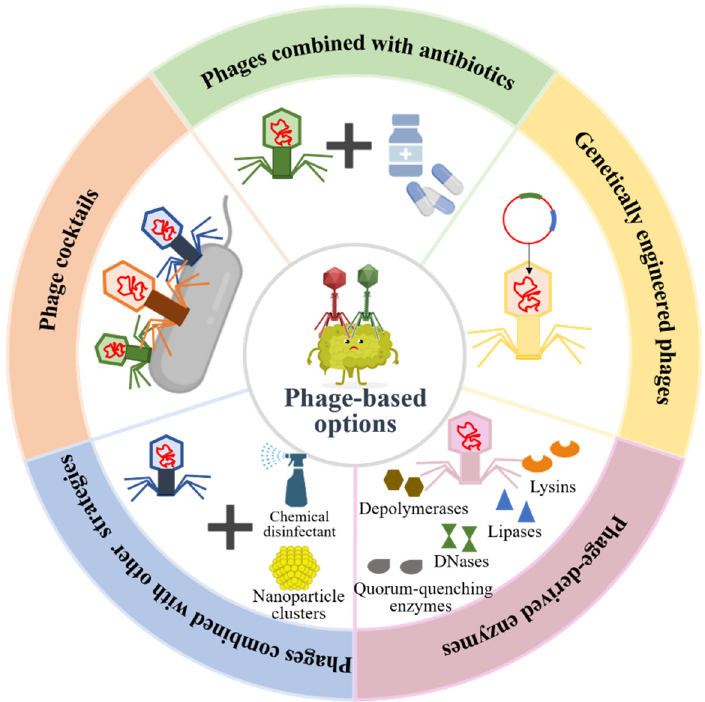
Figure 4. Phage-based therapeutic options in pathogenic bacterial biofilm preventions and de- structions.